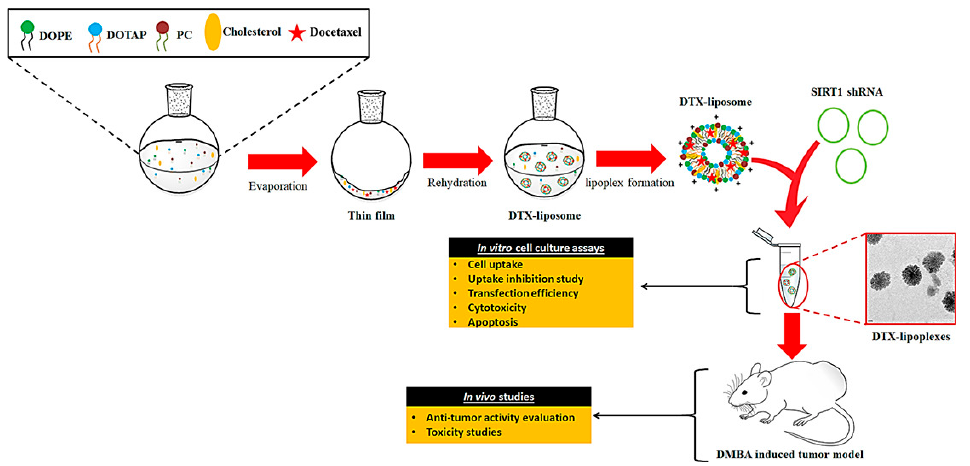
Figure 4. Schematic representation of DTX-Lipoplex pH-responsive nano-drug delivery system in vitro and in vivo. Reproduced with permission from ref. [90] Copyright © 2020, Elsevier. Table 1. Recent examples of liposome-based drug delivery systems for breast cancer therapy.